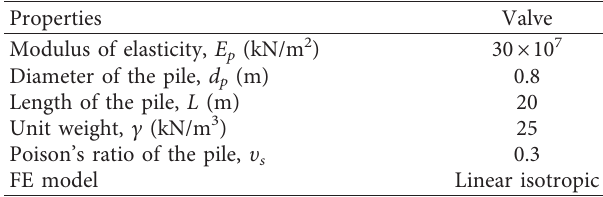
Table 2: Pile properties.